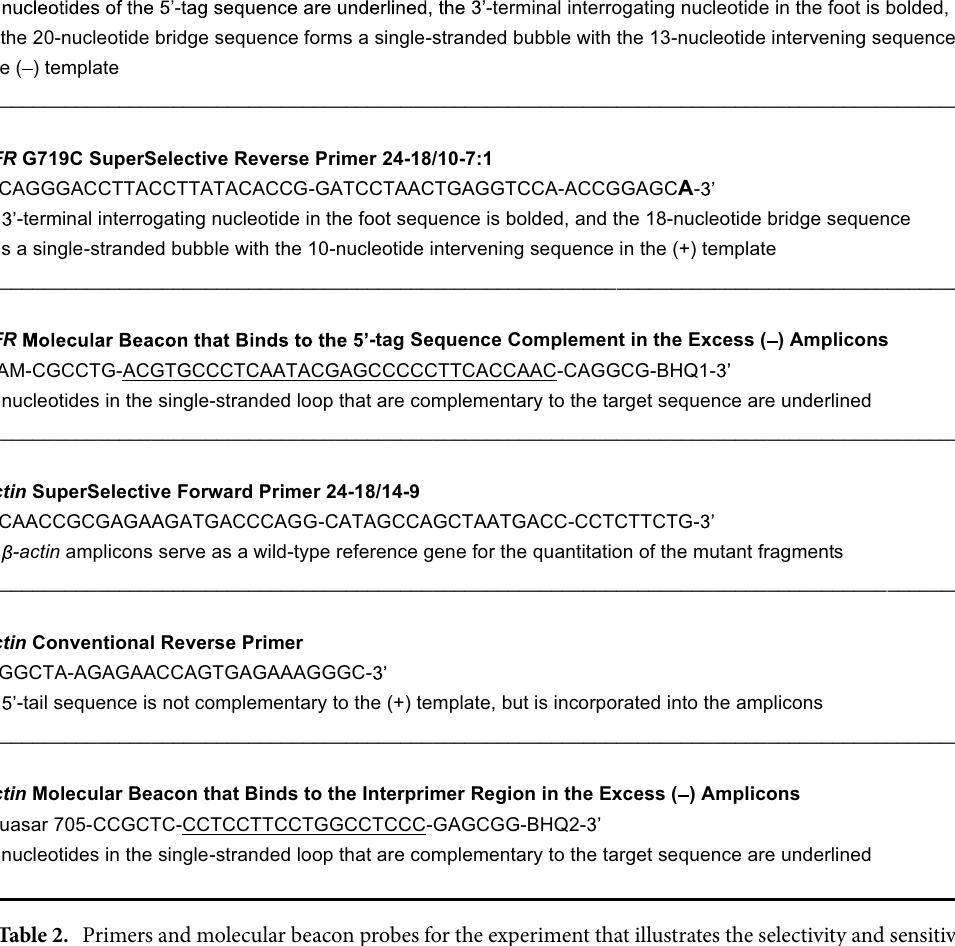
-CCAGGGACCTTACCTTATACACCG-GATCCTAACTGAGGTCCA-ACCGGAGC A - -terminal interrogating nucleotide in the foot sequence is bolded, and the 18-nucleotide bridge sequence forms a single-stranded bubble with the 10-nucleotide intervening sequence in the (+) template _________________________________________________________________________________________________ EGFR -tag Sequence Complement in the Excess ( ) Amplicons -FAM-CGCCTG-ACGTGCCCTCAATACGAGCCCCCTTCACCAAC-CAGGCG-BHQ1- The nucleotides in the single-stranded loop that are complementary to the target sequence are underlined